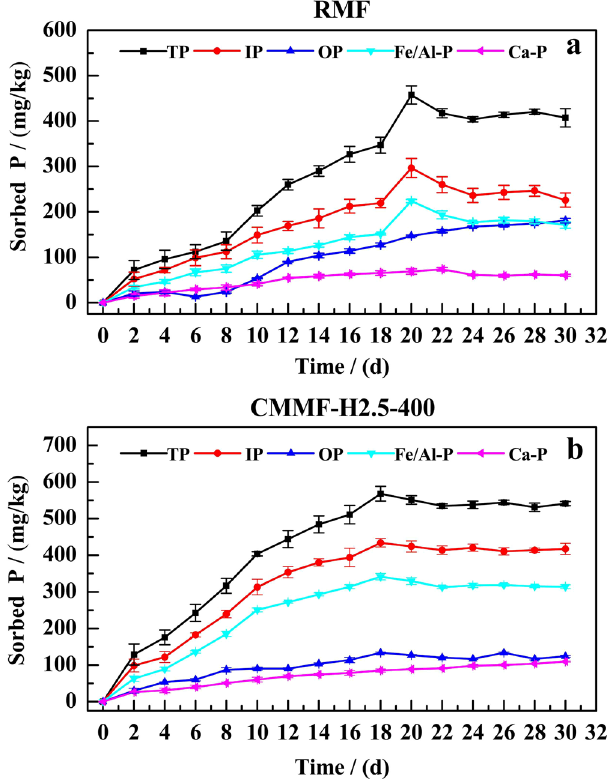
Figure 6. Effects of static time on adsorption performance of RMF ( a ) and CMMF-H2.5-400 ( b